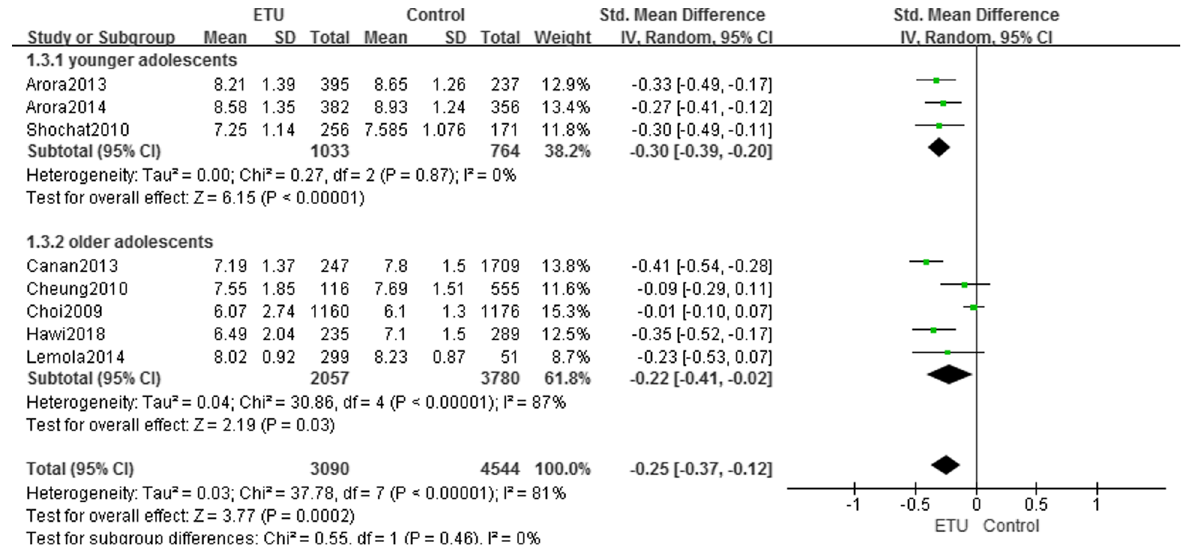
Fig. 2 Sleep duration of adolescents in ETU and control condition. Control condition: no frequently technology